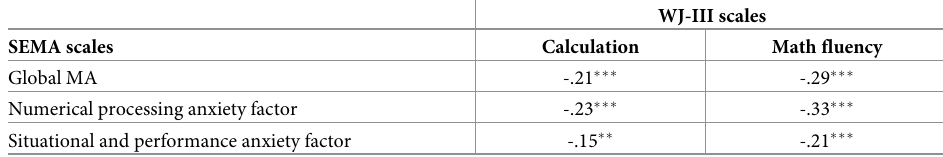
Table 4. Zero-order correlation between math anxiety and WJ-III scale